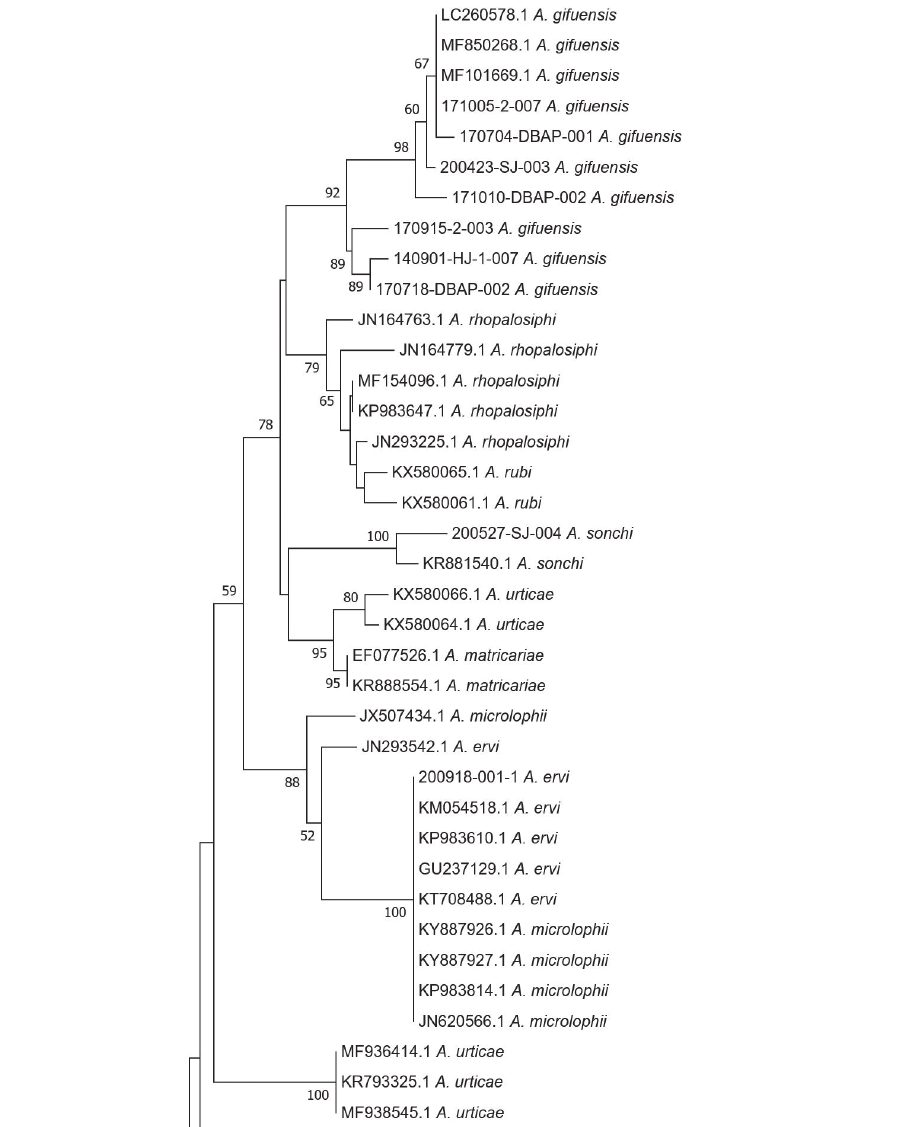
Figure 1. Neighbour-joining tree of 28 Aphidius spp. from South Korea based on their COI DNA bar- code. Diaeretiella rapae was used for an